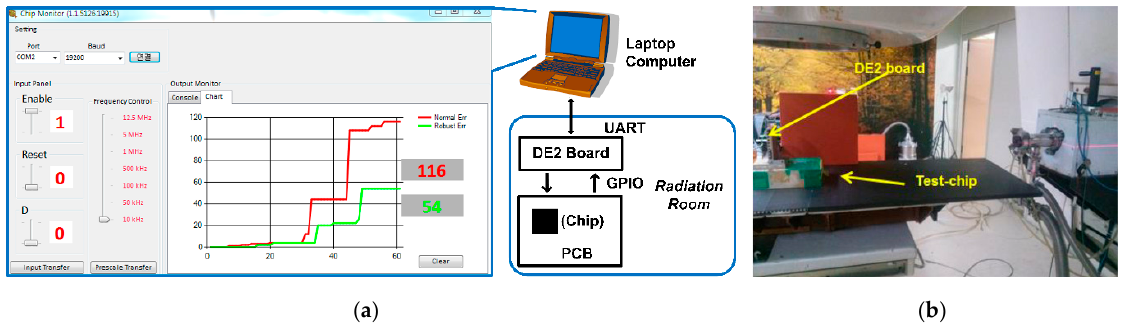
Figure 11. ( a ) Test setup for radiation experiments, ( b ) radiation test facility.